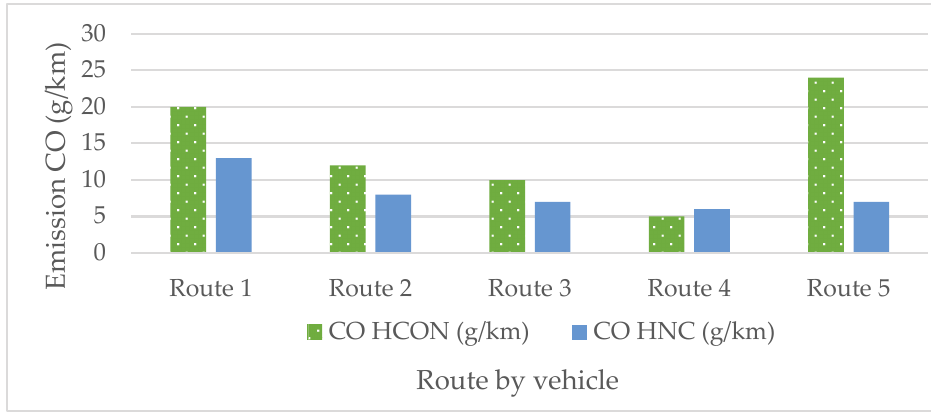
Figure 8. CO emission in HCON and HNC.